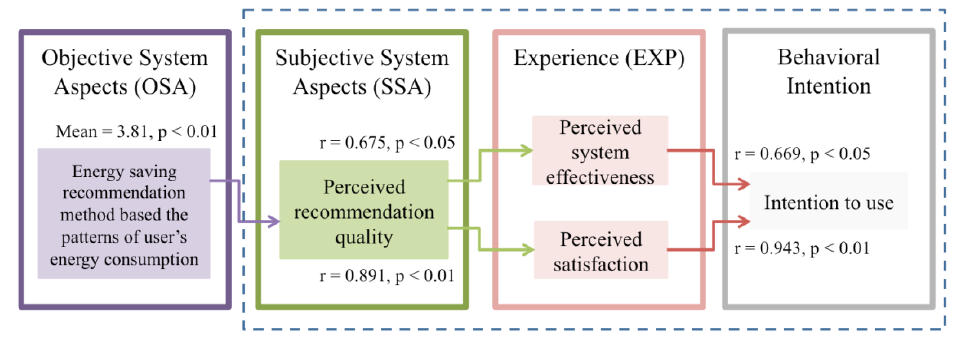
Figure 9. Experiment results.